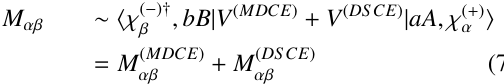
Figure 1. The elementary weak interaction process mediating nuclear 0 ν 2 β decay (left) and a corresponding strong interaction process (right) are depicted schematically. The QCD counterpart is given by the simultaneous emission of two [ d ¯ u ] pairs in an isovector-vector, e.g. 1 − , configuration (wavy lines), decaying into a pionic [ d ¯ u ] configuration and a charge-neutral q ¯ q pair.